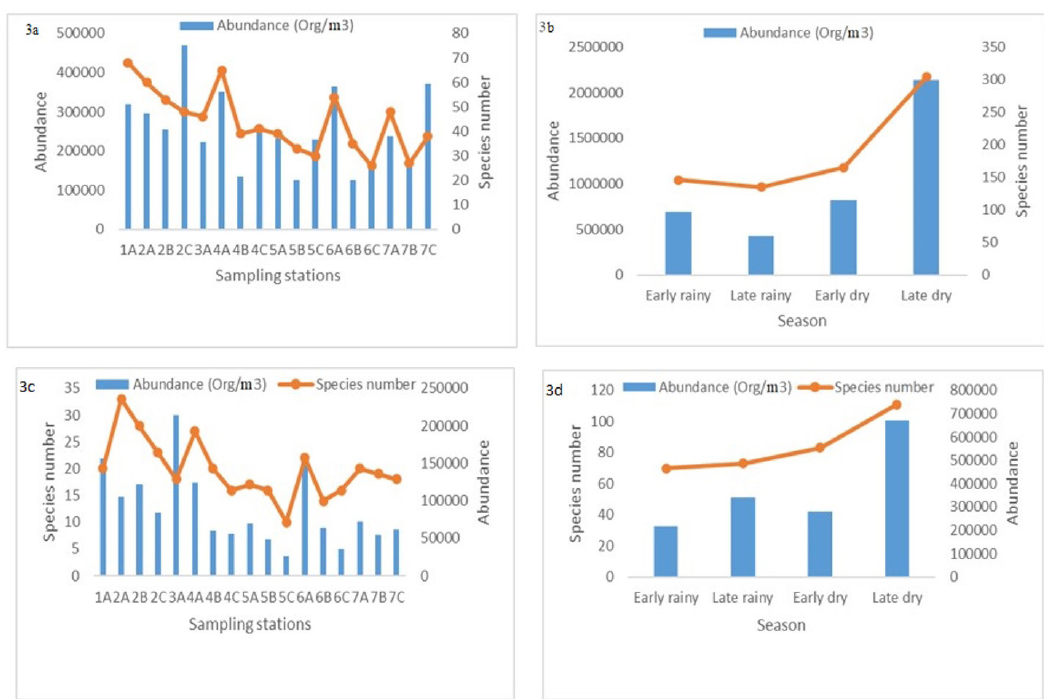
Figure 3. Spatial and seasonal pattern of phytoplankton (a & b) and zooplankton abundance (c & d) in Owalla